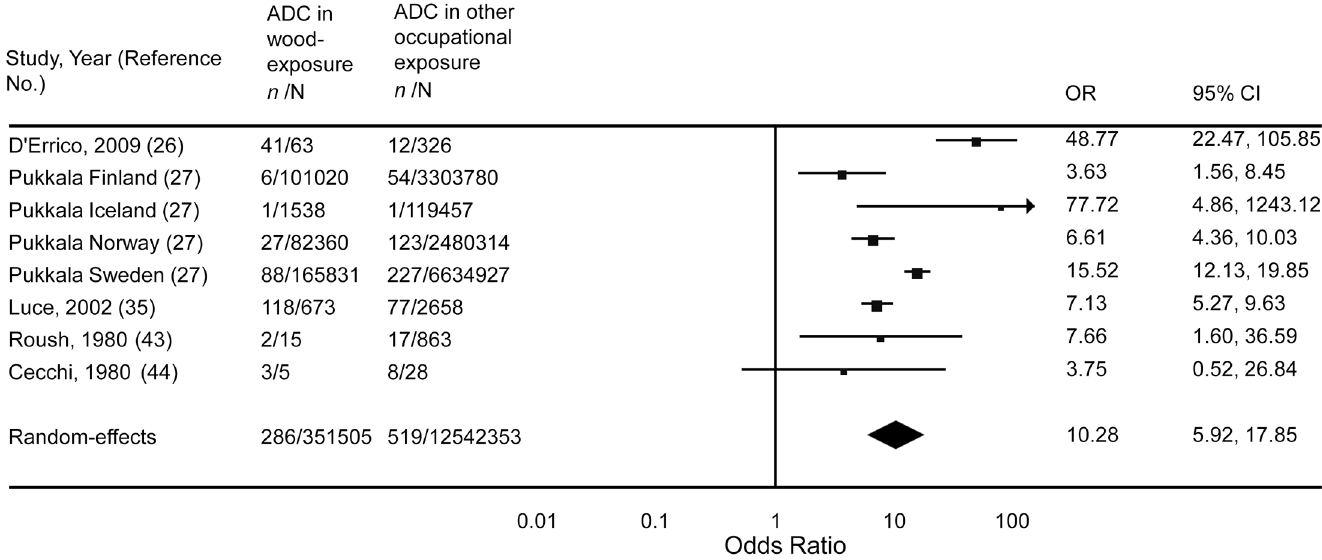
Fig 3. Meta-analysis of the association of sinonasal ADCN with wood exposure. Labor-based wood exposure was compared with other occupational exposures. Test for overall effect: Z = 8.28 ( P < 0.0001). Test for heterogeneity: χ 2 = 46.17 ( P < 0.0001), I 2 = 85%.